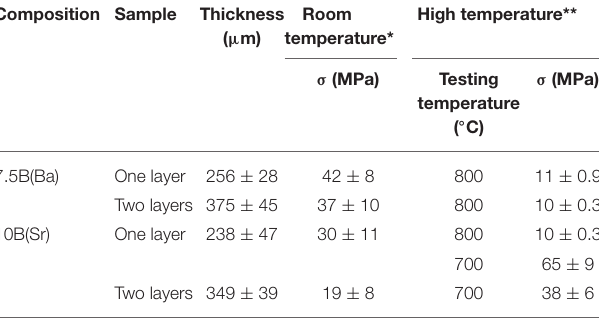
TABLE 6 | Flexural resistance at room and high temperature as a function of the seal